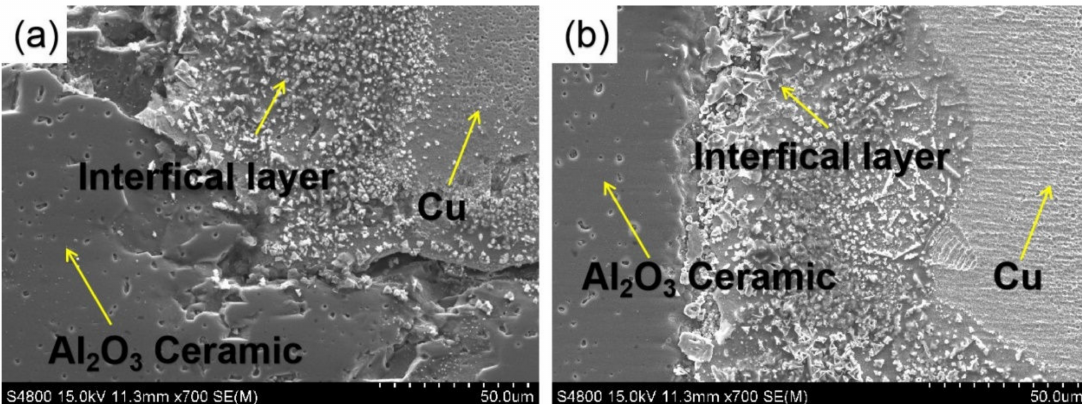
Figure 2. SEM images of Cu / Al 2 O 3 composites at bonded temperature 1300 ◦ C: ( a ) without CeO 2 and ( b ) with CeO 2 .